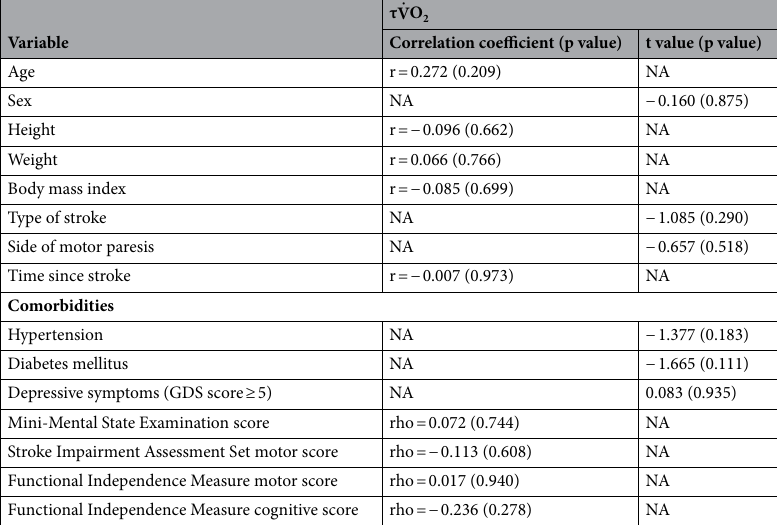
Table 3. Associations between the time constant of oxygen uptake and participants’ characteristics. τ constant of oxygen uptake kinetics, r Pearson’s product-moment correlation coefficient, rho Spearman’s rank correlation coefficient, GDS Geriatric Depression Scale, NA not